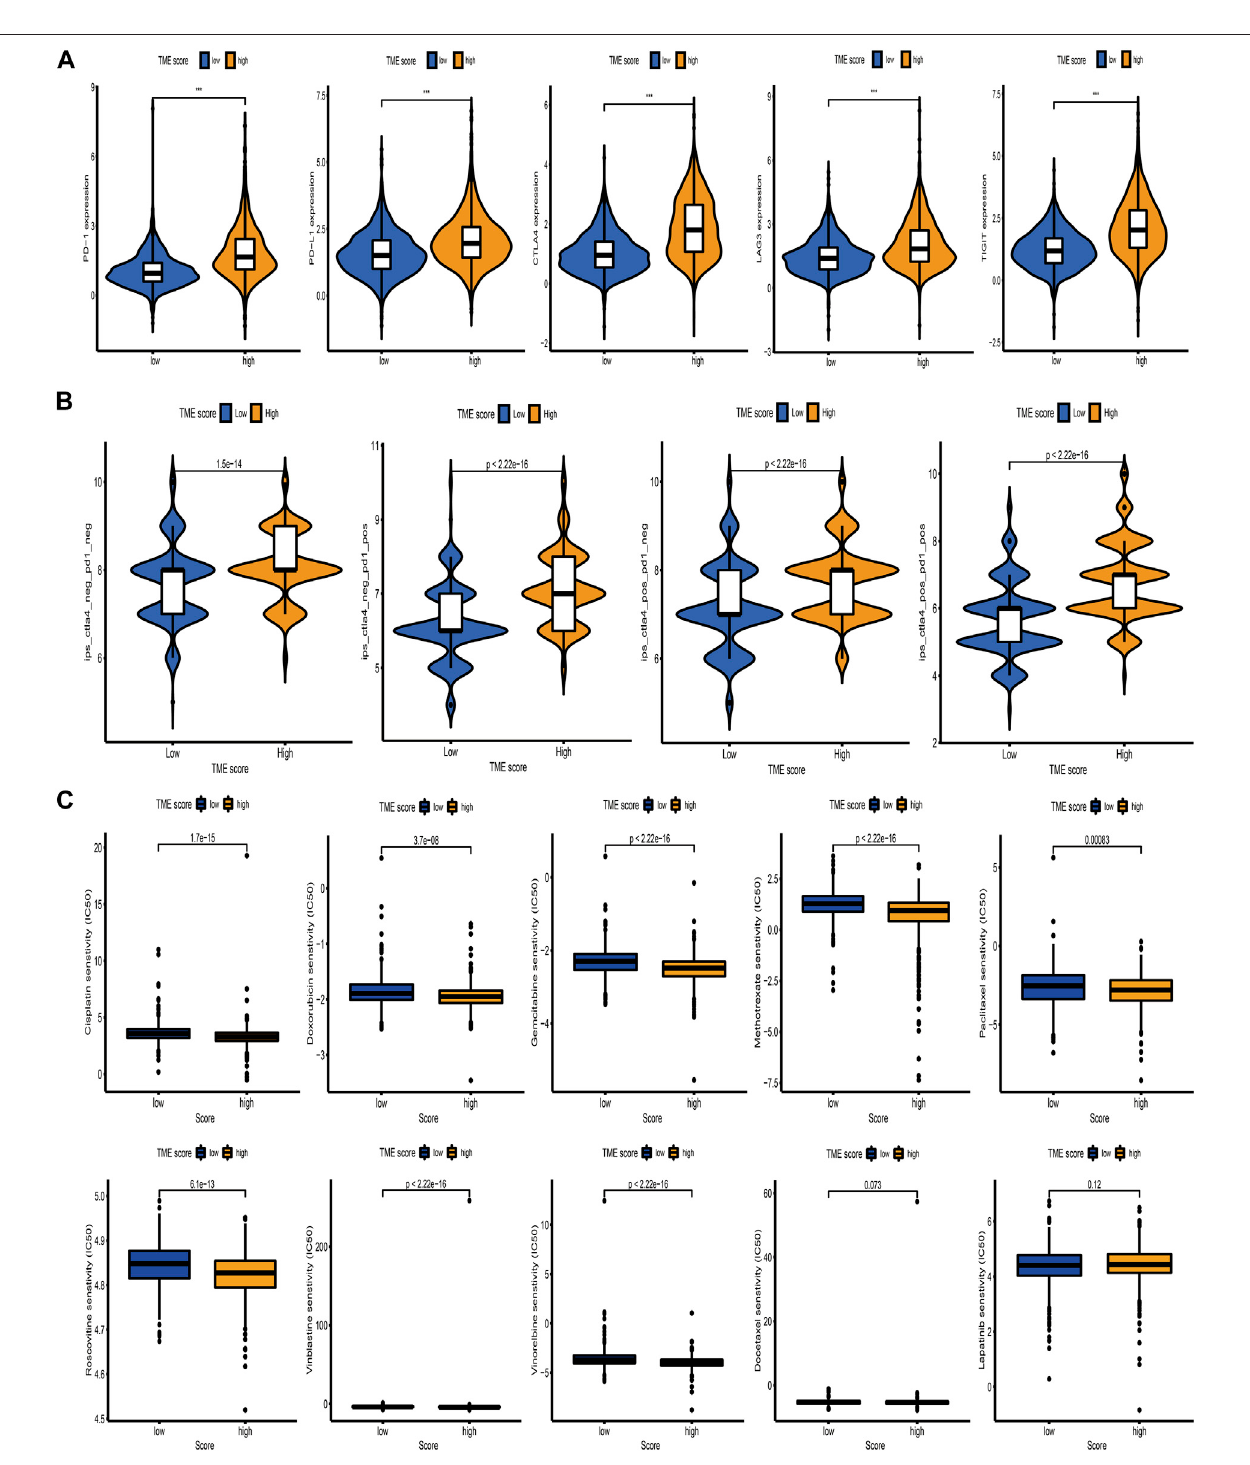
FIGURE 8 | Correlation between the TME-score and immunotherapeutic bene fi ts and chemotherapeutic ef fi cacy. (A) The relative distribution of immunosuppressivemoleculeswascomparedbetweenTME-scorehighversuslowgroupsinthemeta-cohort. (B) Relativedistributionofimmunotherapeuticef fi cacyin highTME-scoreversuslowTME-scoregroups. (C) RelativedistributionofIC50forchemotherapeuticdrugscommonlyusedinclinicalpracticebetweenTME-scorehigh versus low groups.